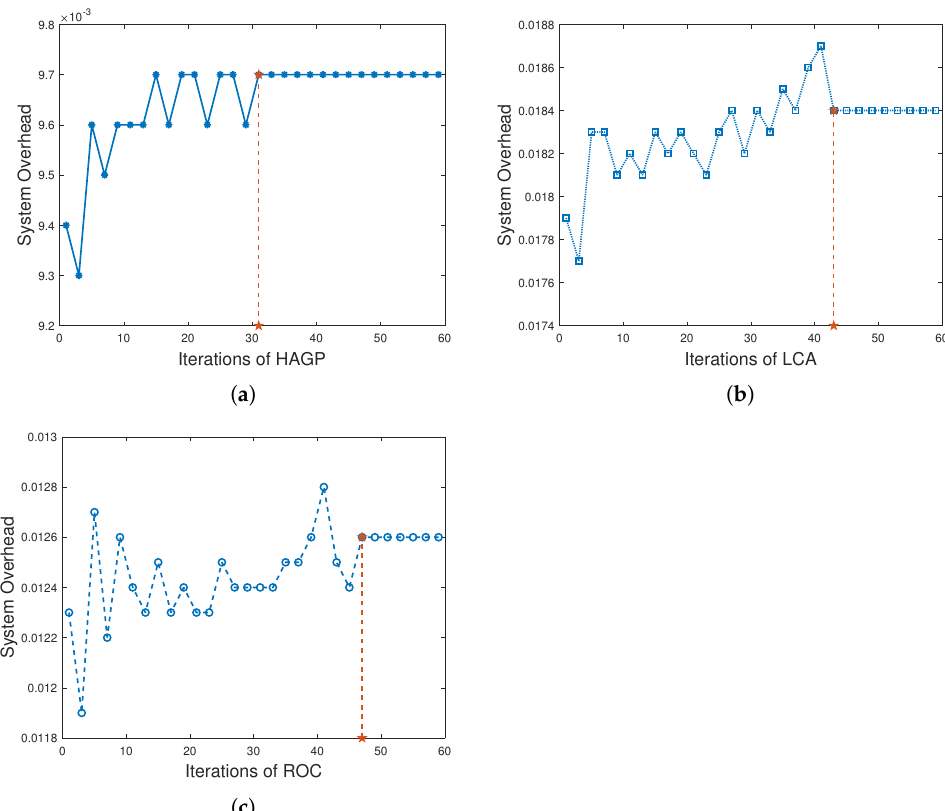
Figure 2. Overall system overhead vs. iterations of all three algorithms. ( a ) HAGP; ( b ) LCA; ( c ) ROC. (2) Impact of the number of MDs on overall system